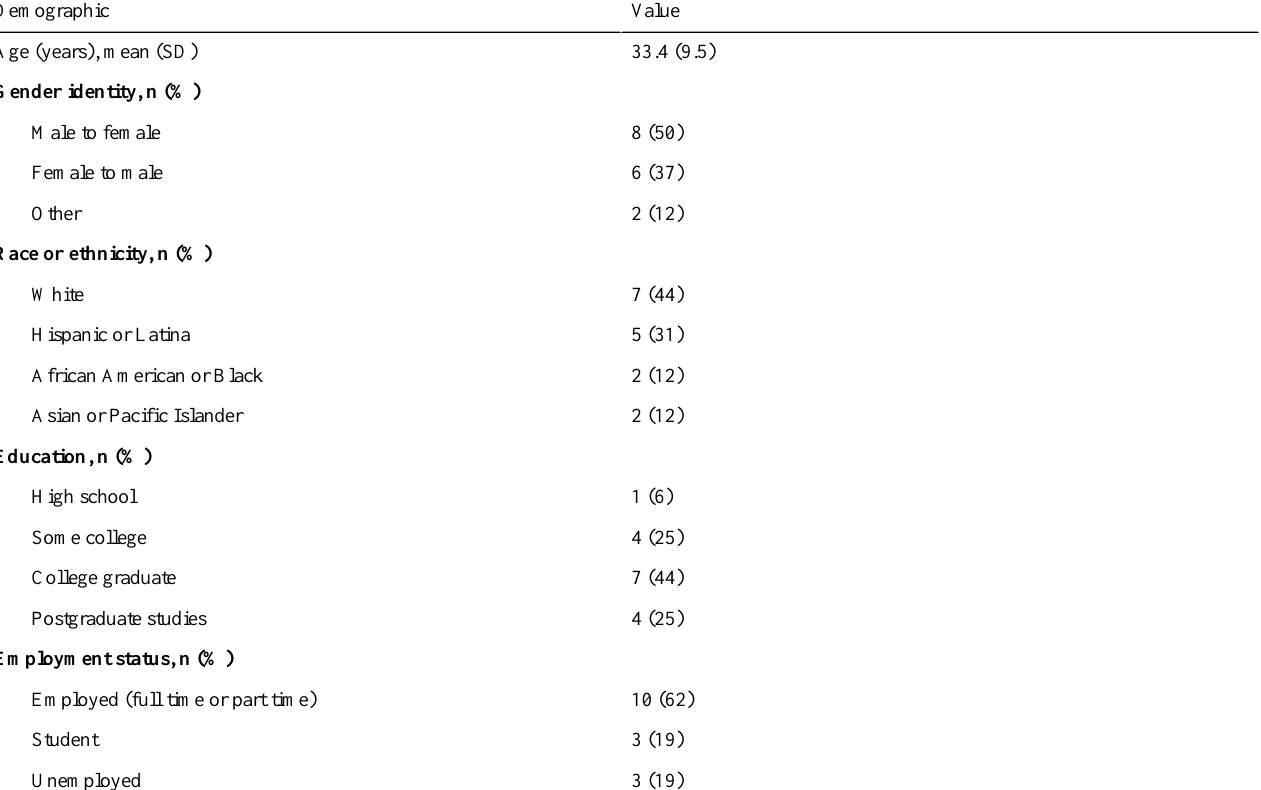
Table 1. Demographics